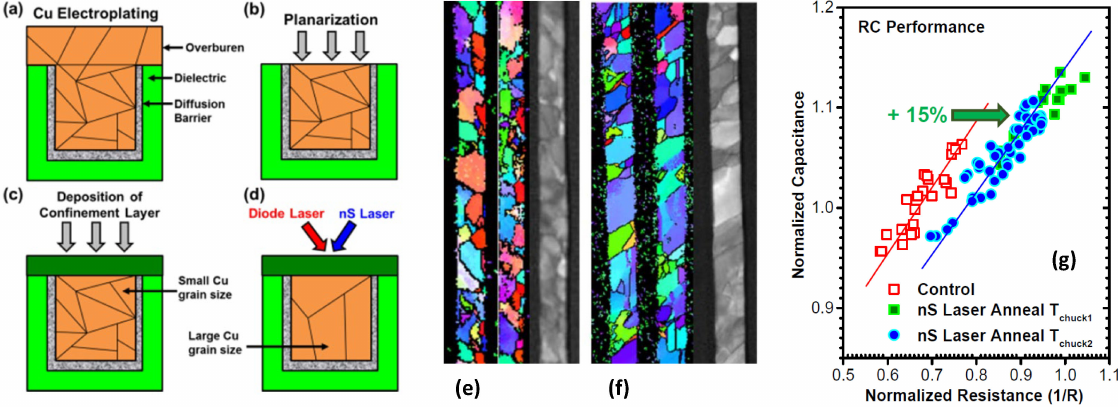
Figure 13. ( a – d ) Schematics of ns LA process flow, ( e , f ) grain analysis performed in the control and Cu melt ns LA lines, ( g ) RC performance measured in the control and Cu melt ns LA lines. Reprinted/adapted with permission from Ref. [75]. 2018, IEEE.